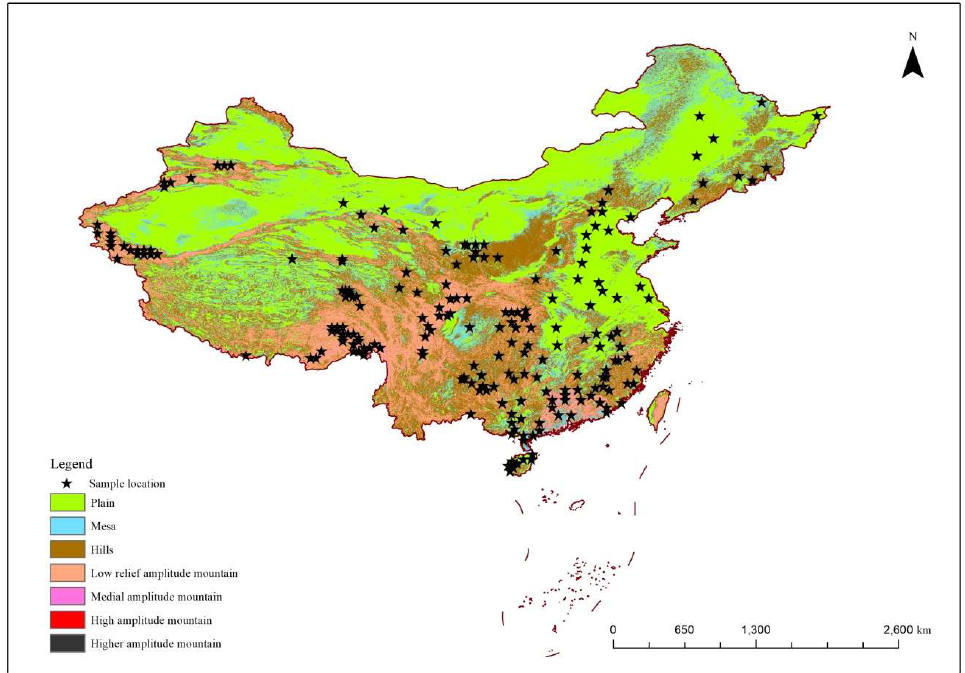
Figure 4. Distribution of 210 samples.